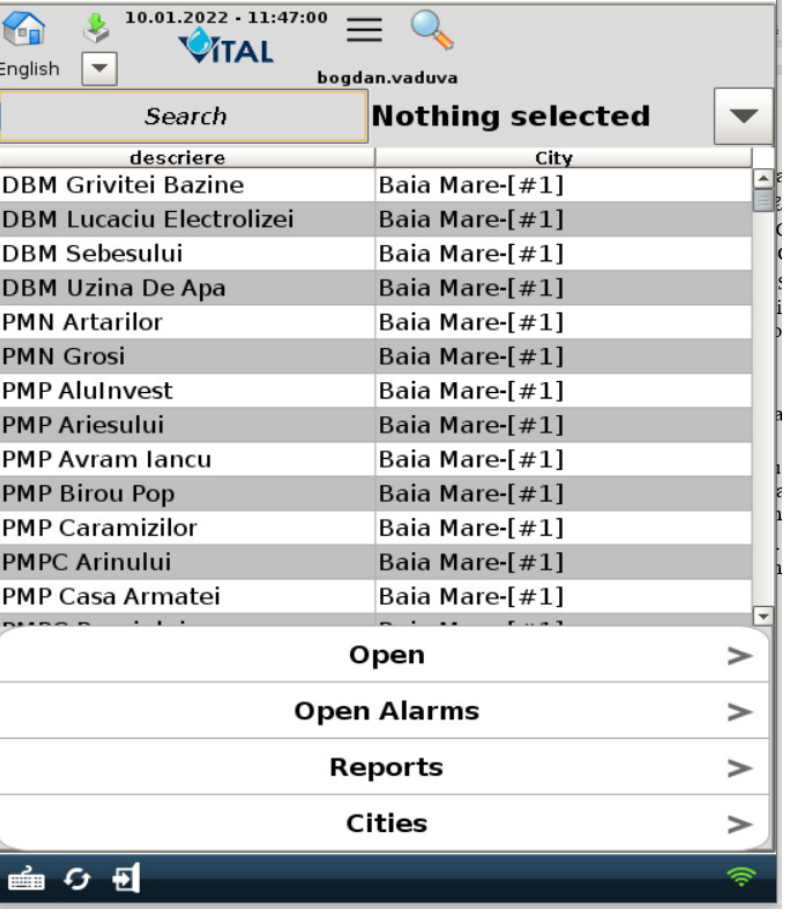
Figure 6. Default mobile view for both Administrator and Operator role.